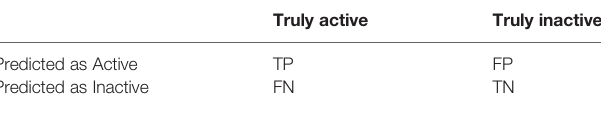
TABLE 1 | Classi fi cation